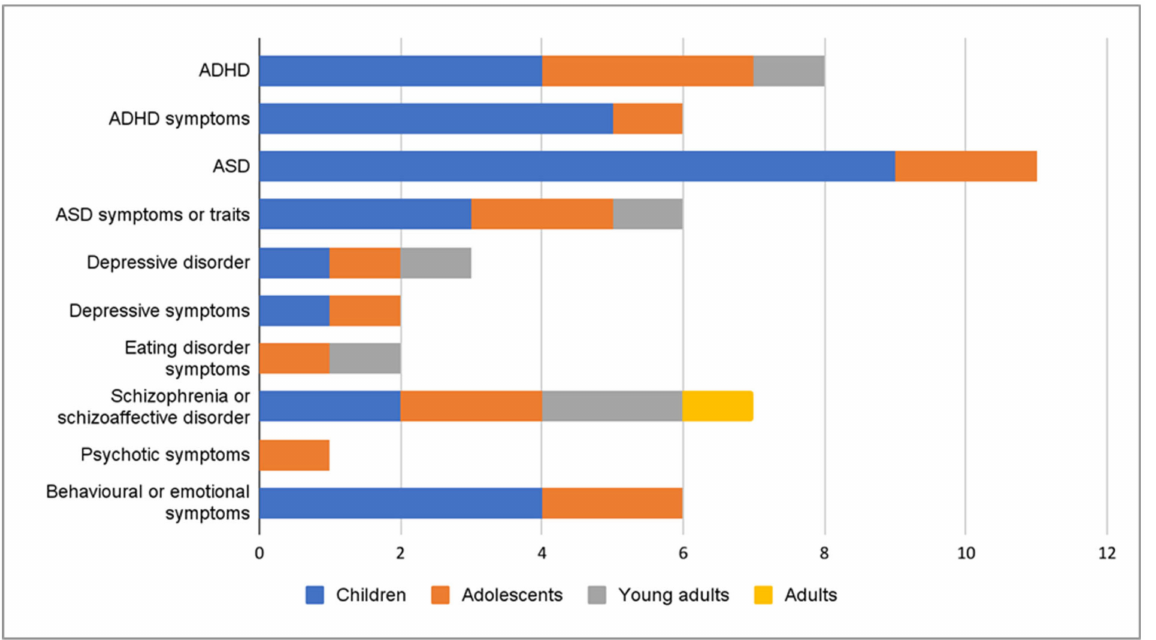
Figure 2. The number of studies for each outcome, stratified by the age groups assessed in the study. Some studies examined multiple outcomes and multiple age